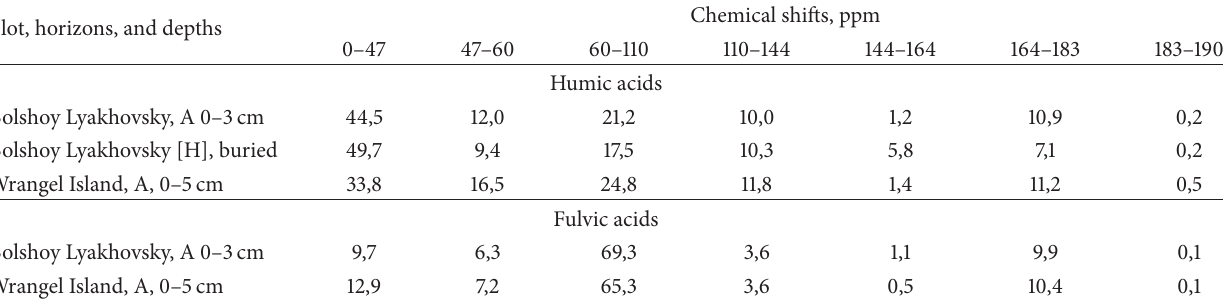
Table 3: Percentage of carbon in the main structural fragments of HAs and FAs (according to 13 b NMR). Plot, horizons, and